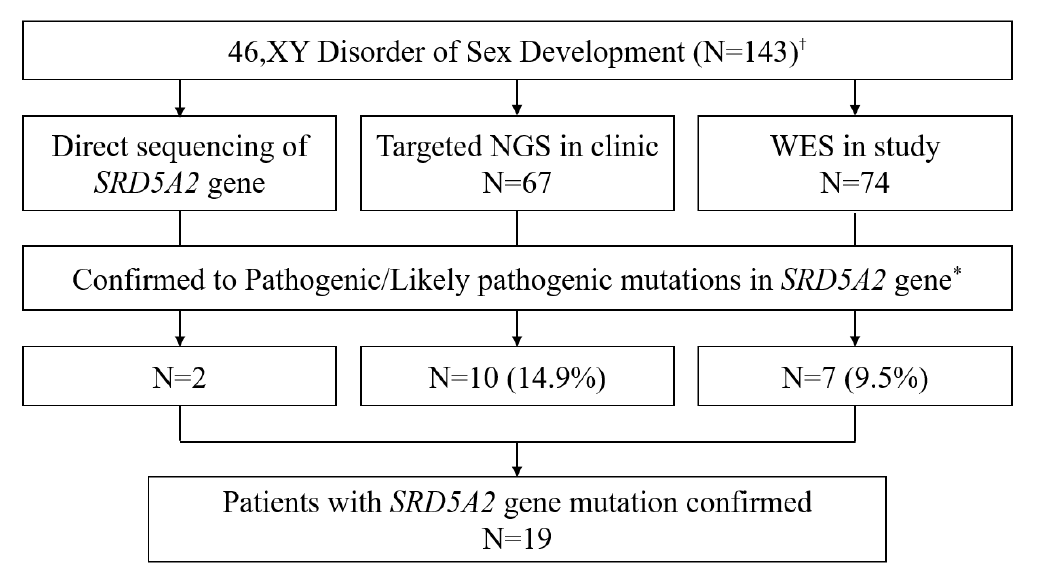
Figure 5. Participant selection for this study. † Patients who had already been diagnosed genetically with different diseases or refused genetic testing were excluded. * According to the American College of Medical Genetics and Genomics guidelines.